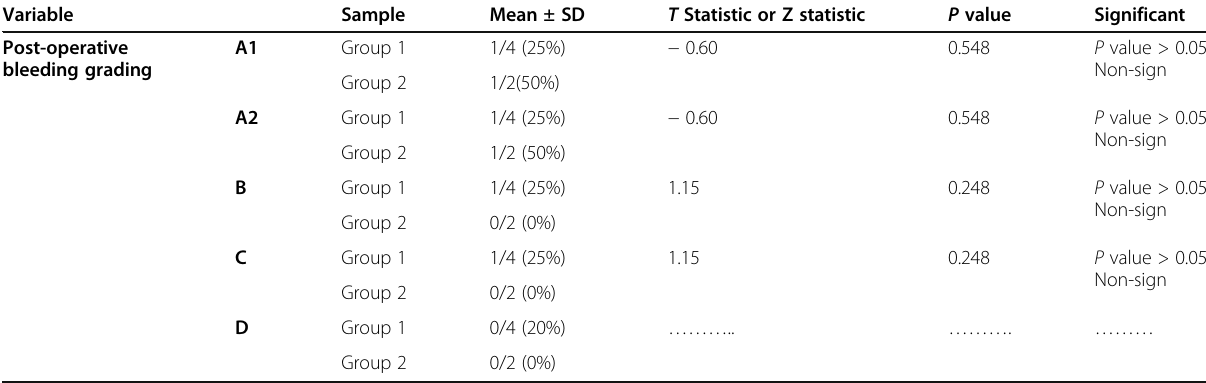
Table 7 The distribution of post-tonsillectomy bleeding grading